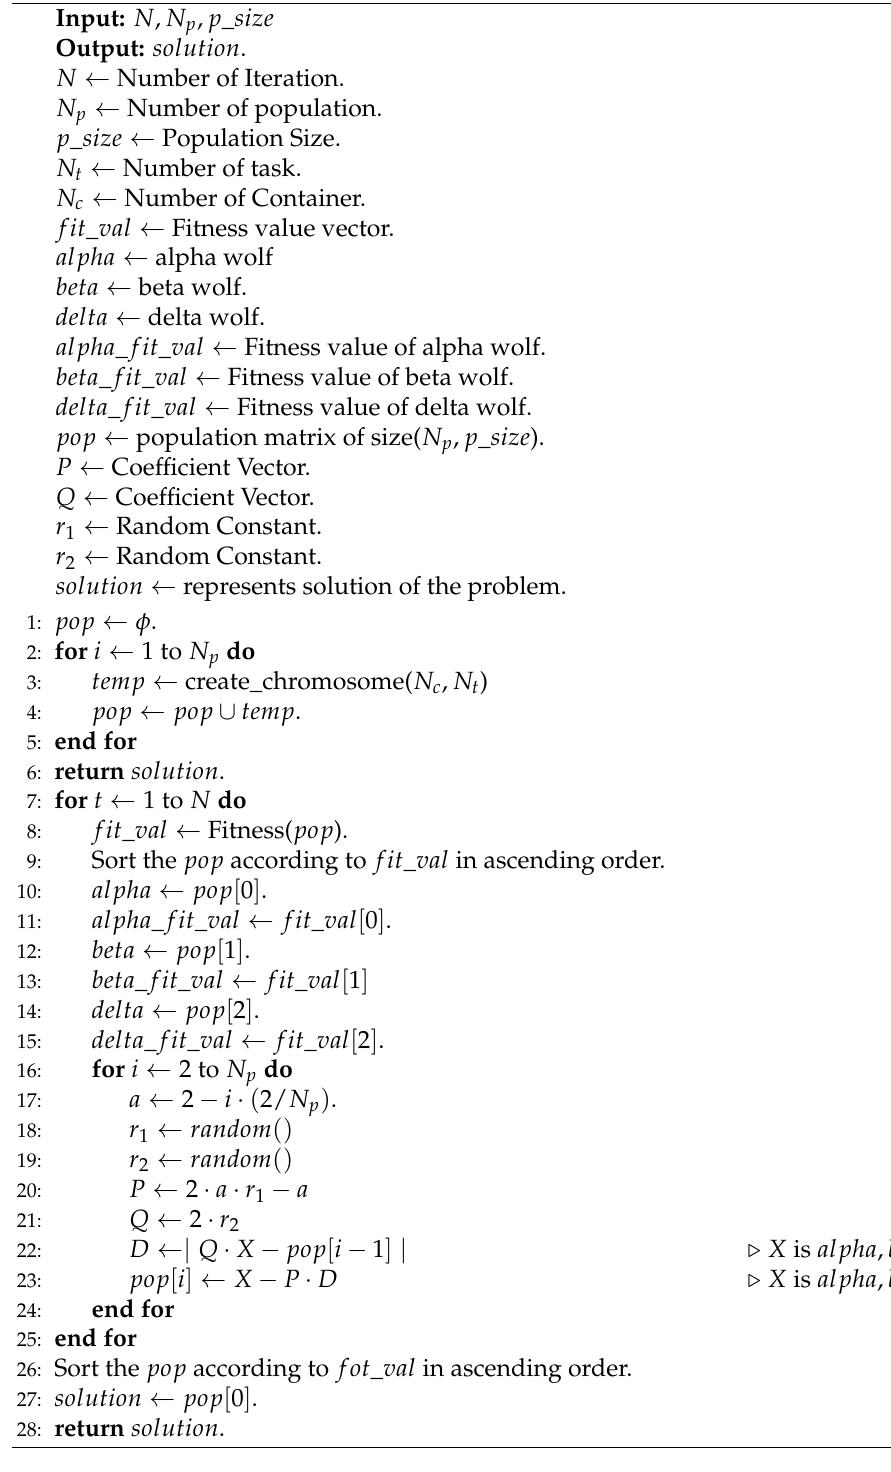
Algorithm 2 Grey Wolf optimization